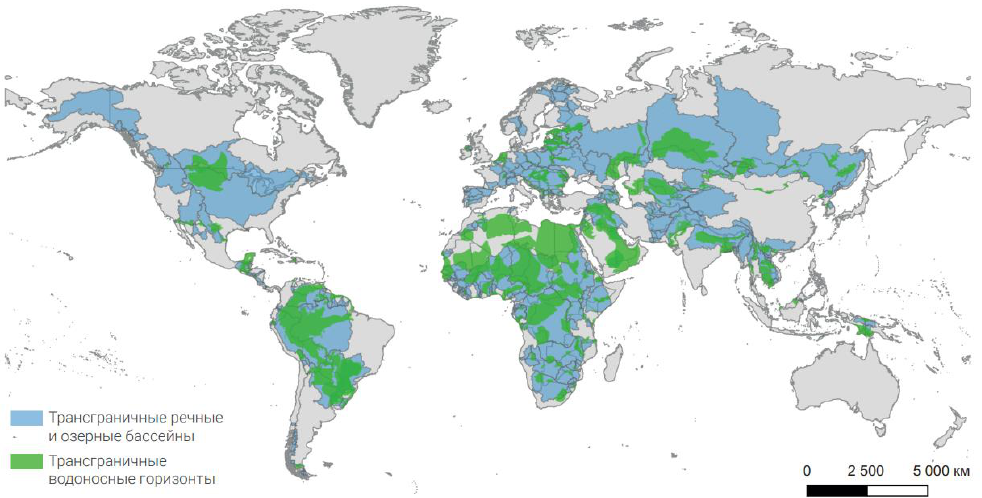
Figure 1. Transboundary river and lake basins, transboundary aquifers and international borders [5].